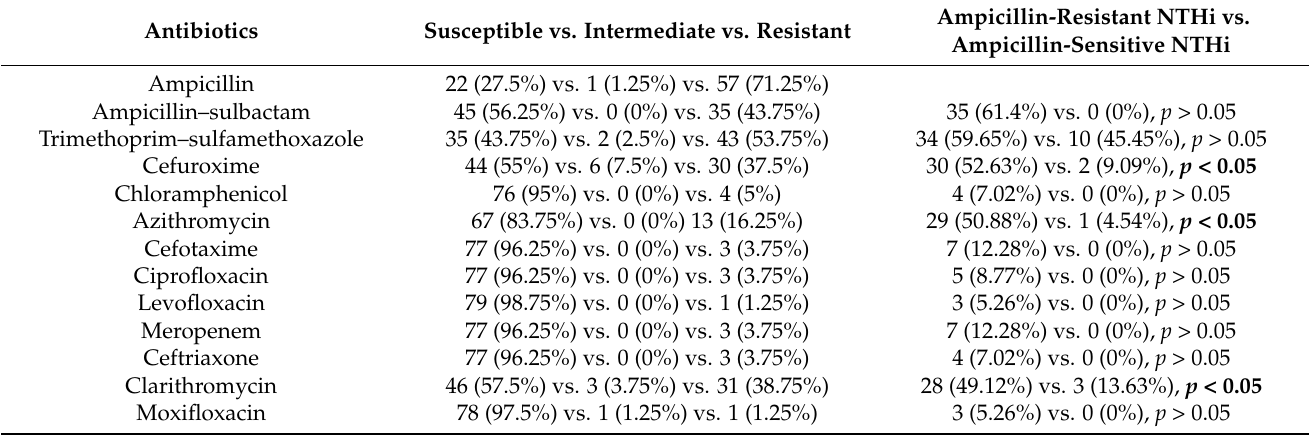
Ampicillin-Resistant NTHi